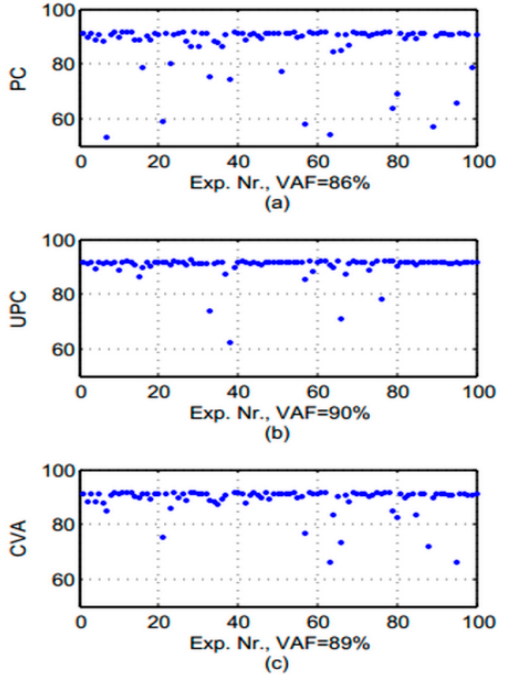
Figure 6. The variance accounted for (VAF) values for ( a ) CVA, ( b ) UPC, and ( c ) PC algorithms.